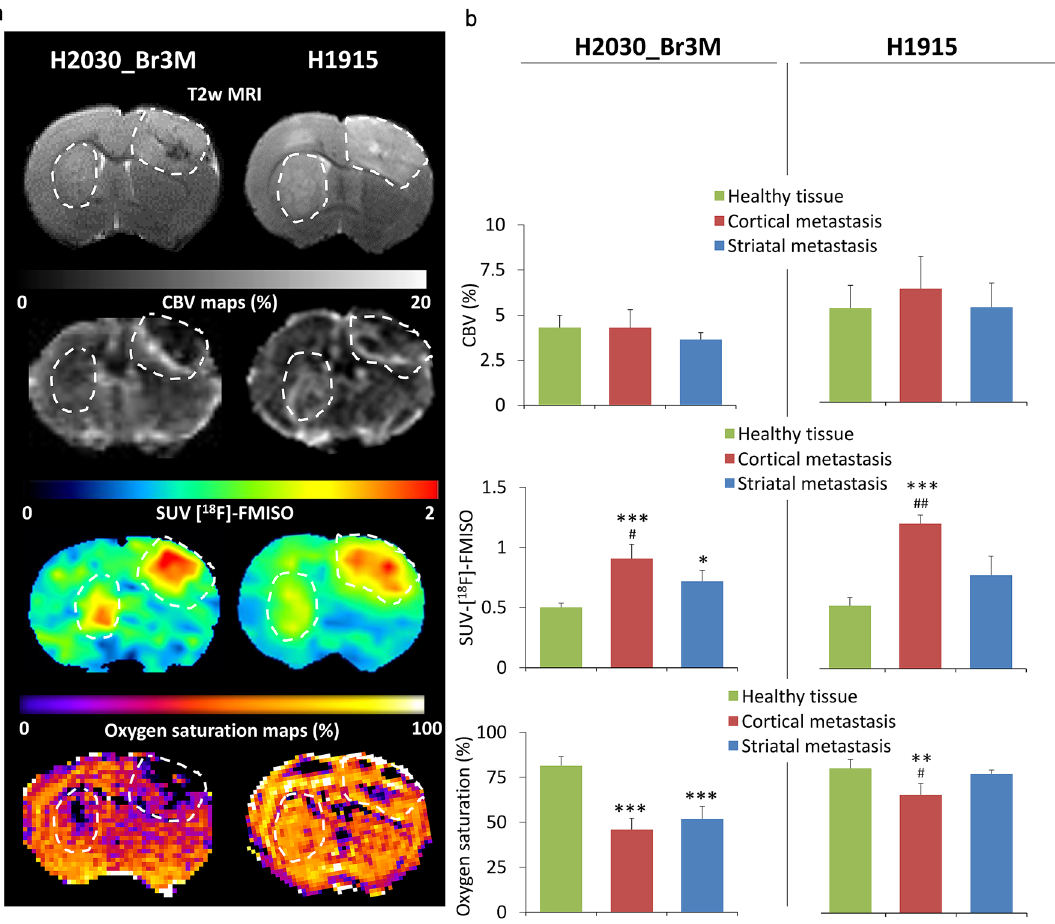
Figure 5. Multimodal imaging characterization of vascularization and hypoxia. ( a ) Representative images of H2030-Br3M and H1915 brain metastases (right and left respectively, hatched line). From the top to the bottom: T2w MRI, CBV-MRI map, [ 18 F]-FMISO-PET and Oxygen saturation-MRI map. ( b ) Quantitative analyzes of multimodal imaging characterization. From top to the bottom: CBV (%), SUV-[ 18 F]-FMISO and Oxygen saturation (%). Mean ± SD, n = 3 for H1915 and n = 4 for H2030-Br3M model, * p < 0.05, ** p < 0.01 and *** p < 0.001 versus healthy tissue and # p < 0.05 and ## p < 0.01 versus striatal